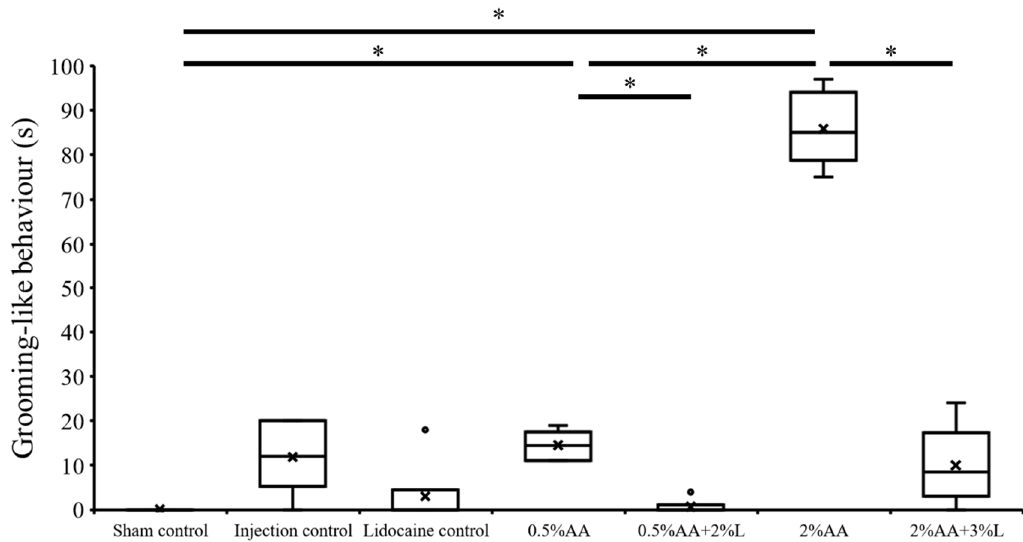
Figure 3. Injection of acetic acid induces grooming behaviour in cuttlefish and that injection of lidocaine reduces grooming behaviours in acetic acid injected cuttlefish. The dots indicate the data points outside the upper and lower quartiles. * p < 0.05.